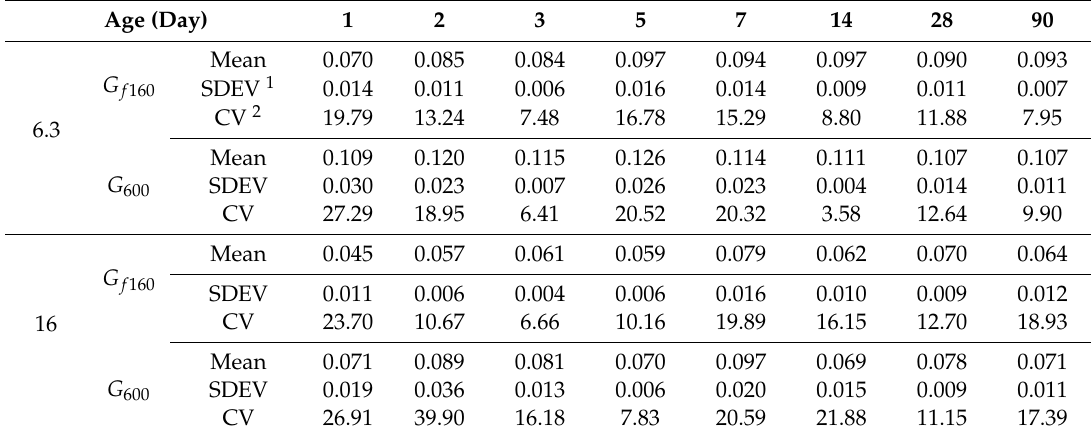
Table 2. Fracture energy (N / mm) vs. the age of the